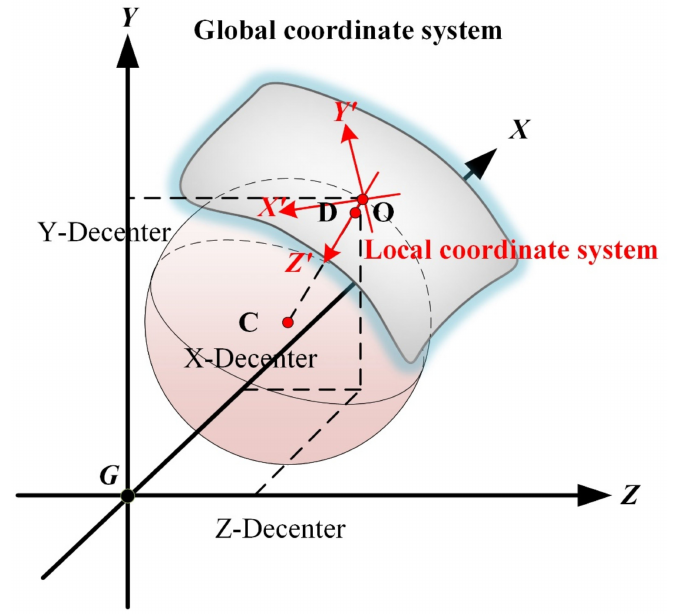
Figure 4. Define the Z (cid:48) axis and origin of the local coordinate system. The direction of the red arrow is the Z (cid:48) axis direction, and the origin is the red dot marked with O